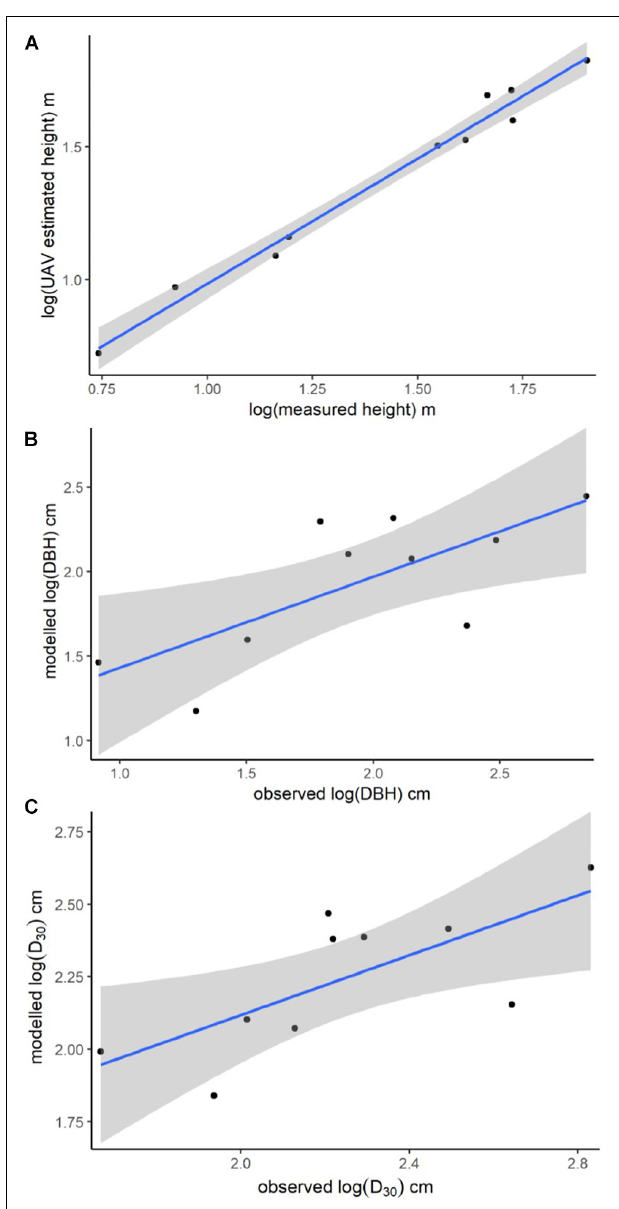
FIGURE 4 | Plots of UAV image-based model-predictions against physically measured values. (A) Linear model showing the relationship between the logged measurements of tree height from the UAV image-based structure-from-motion point cloud and the logged measurements of tree height taken from the felled trees. Linear model predictions of (B) log (DBH) as a function of UAV image-based measurements of tree height plotted against the log of physical measurements of tree DBH; and (C) log (D 30 ) as a function of UAV image-based measurements of tree height and canopy area plotted against the log of physically measured tree D 30 . Shading = 95% confidence